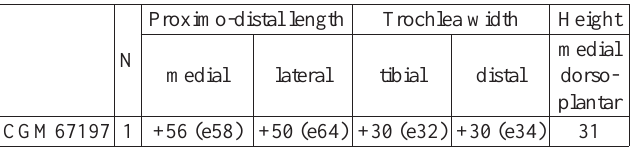
Table 3. Dimensions (in mm) of an anthracotheriid astragalus, cf. Bo- thriogenys sp., from the BOTM at Minqar Tibaghbagh, Qattara De- pression, Egypt. Abbreviations: e, estimated dimension; N, number of specimens; +, indicates dimensions of the fossil were originally greater (damaged specimen). Proximo-distal length Trochlea width Height N medial lateral tibial distal